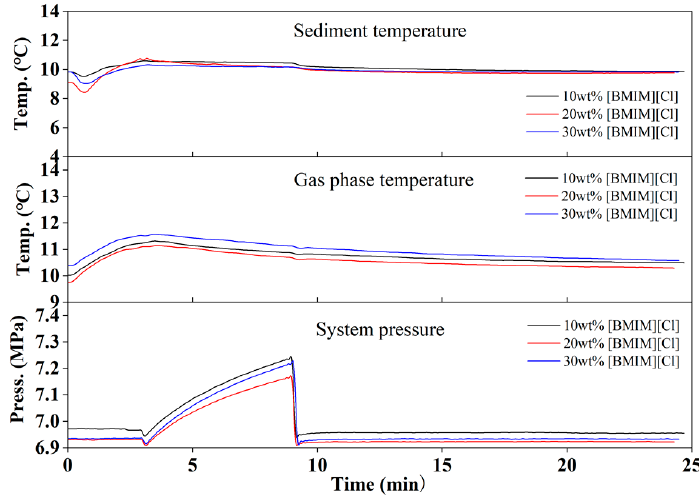
Figure 8. E ff ect of BMIM-Cl concentration on gas production. Figure 8. Effect of BMIM-Cl concentration on gas